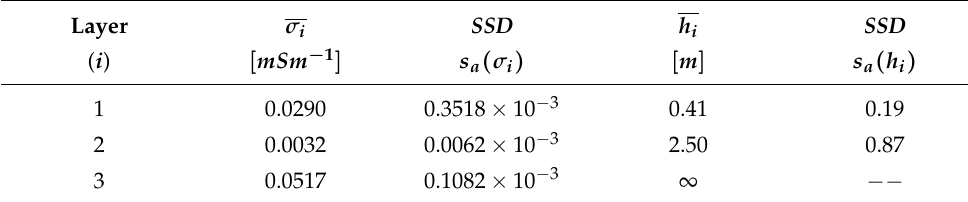
Table 8. Mean values and sample standard deviations of 3D mapping of Leptosol.